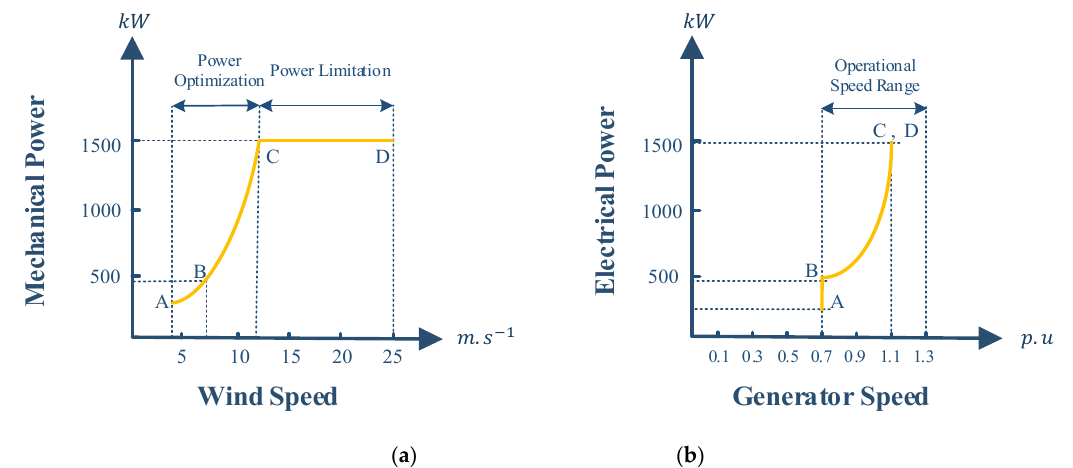
Figure 2. Illustration of the design curves of the DFIG WT test system. ( a ) Output mechanical power base on wind speed and ( b ) electrical power based on the speed of the generator.